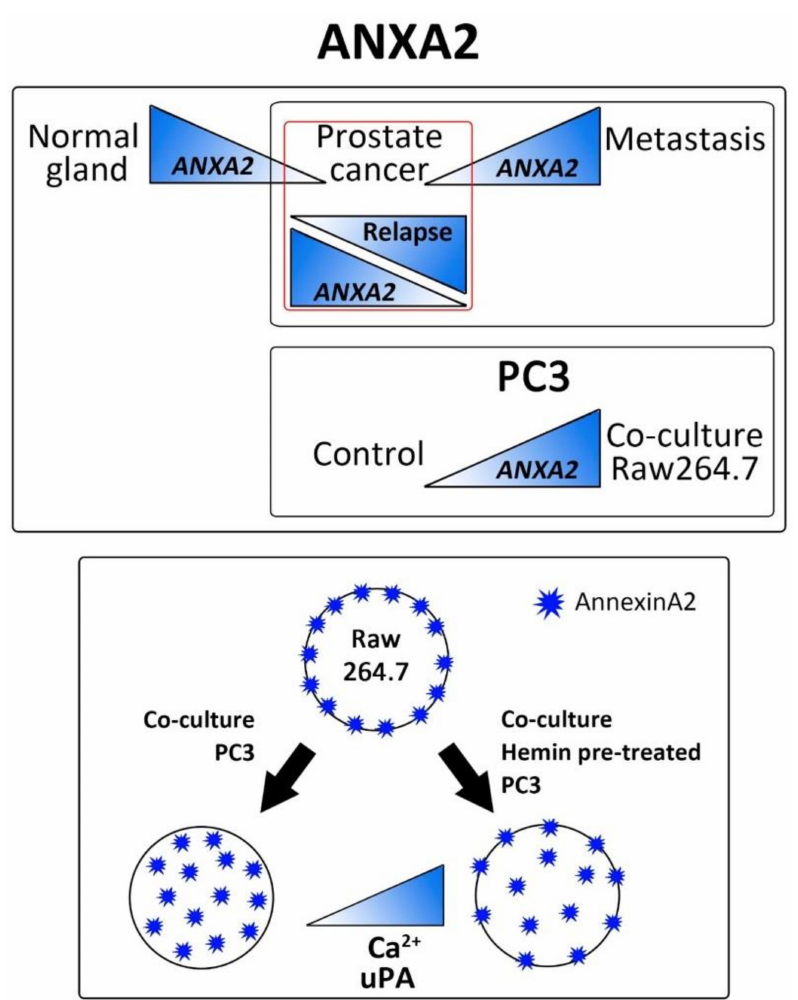
Figure 7. Schematic representation of ANXA2 and HO-1 expression in PCa and metastasis. ANXA2 expression is downregulated in prostate carcinoma compared with the normal gland. In PCa bone metastasis there is an increase in ANXA2 expression compared with the primary tumor site. Similarly, the presence of bone cells in the co-culture induces an increase in ANXA2 expression in the tumor cell, reflecting that the bone niche modulates the expression of ANXA2 in the prostate tumor cell. In turn, the presence of tumor cells triggers a change in the sub-cellular localization of ANXA2 in the pre-osteoclastic cells. This e ff ect is hampered under HO-1 induction in PC3 cells. This phenomenon could be explained, at least in part, by the di ff erences in the availability of free calcium in both conditions and the presence of urokinase (uPA) in the conditioned